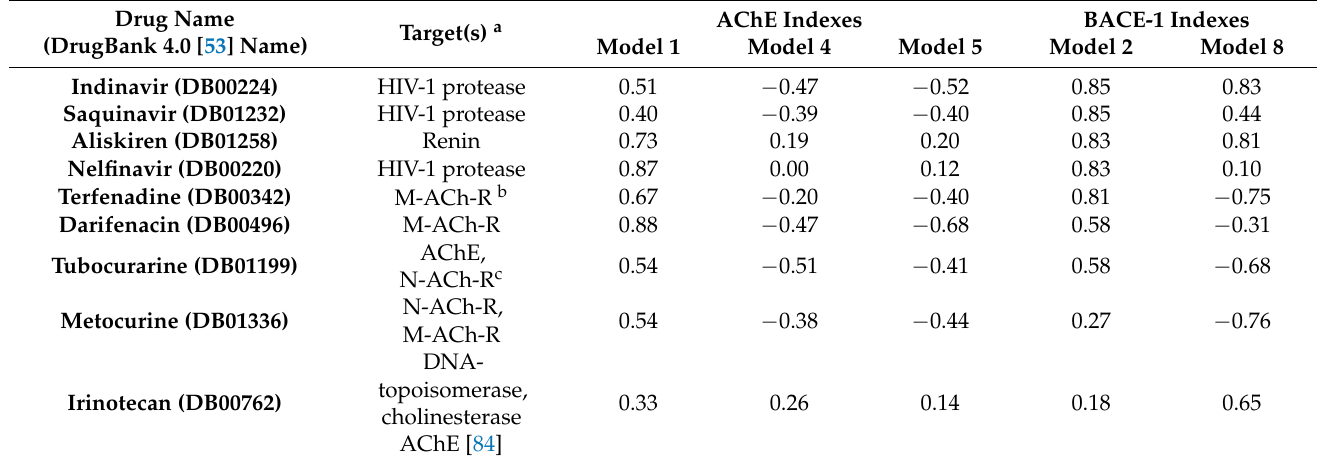
Table 3. Potentially repurposed drugs from DrugBank-Approved.